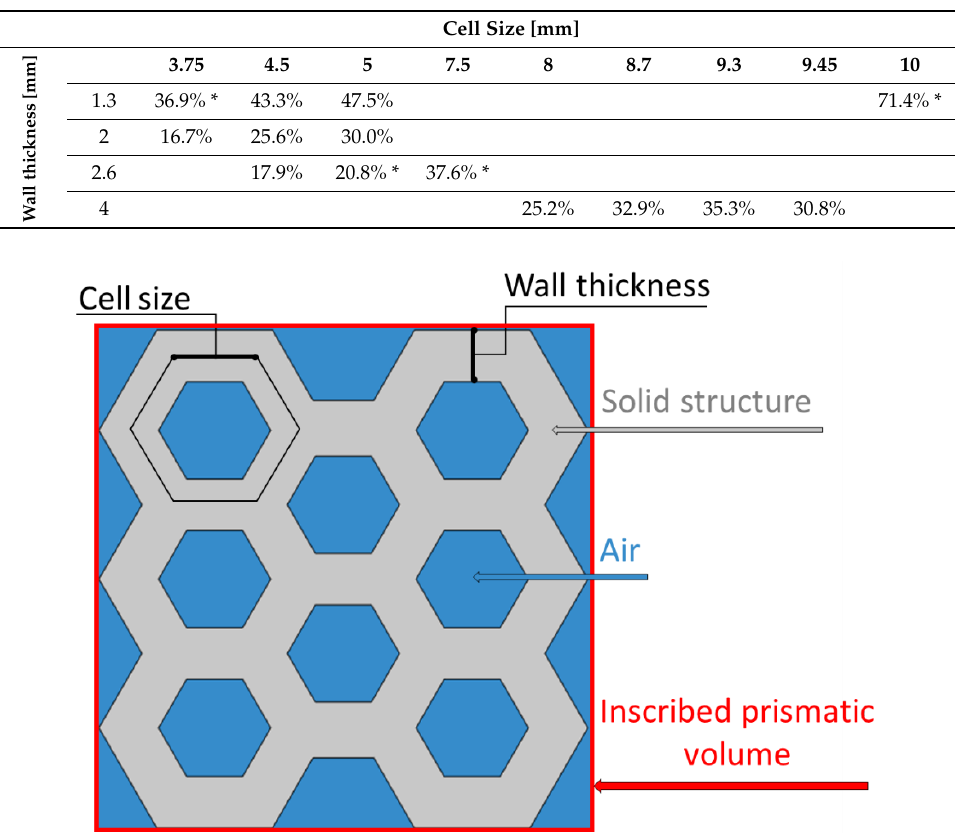
Table 3. Summary of the geometries studied through FEM with their respective porosity values (in the table cells). Geometries marked with * were 3D printed and experimentally tested.